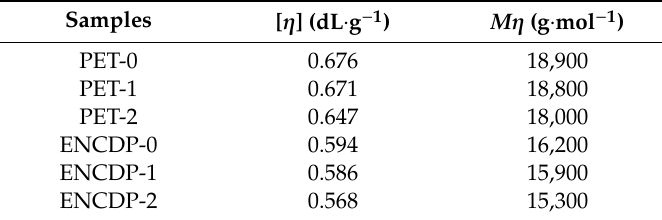
Table 2. The intrinsic viscosity and M η of the copolyesters.